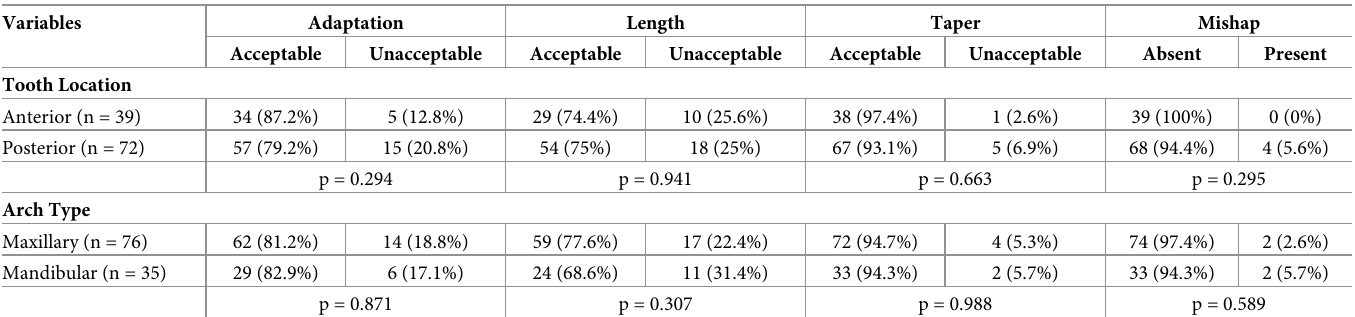
Table 3. Quality of root canal fillings according to tooth location and arch